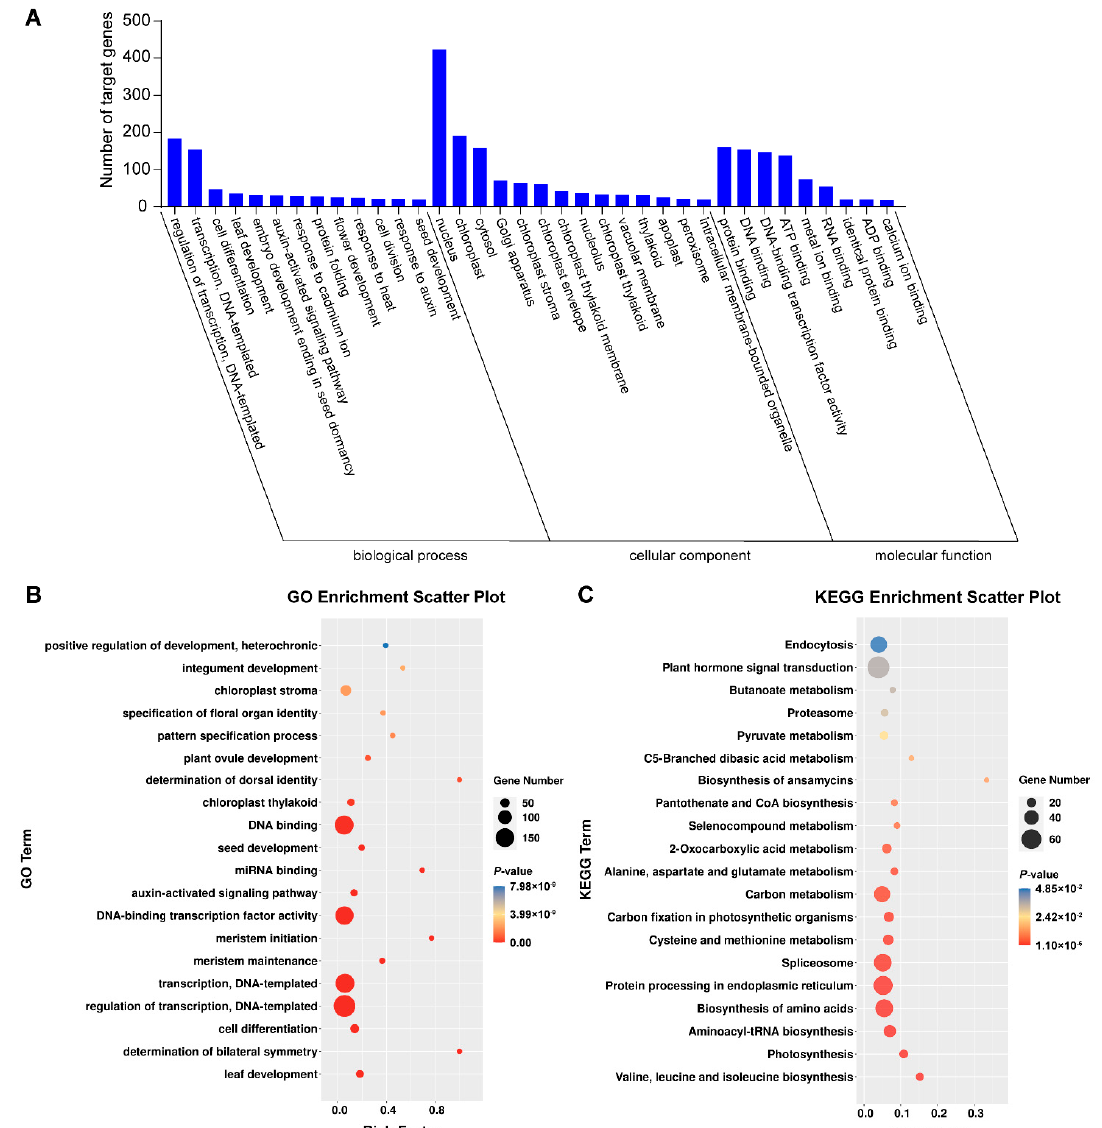
Figure 4. Gene Ontology (GO) ( A ) and Kyoto Encyclopedia of Genes and Genomes (KEGG) ( B , C ) analysis of target genes in degraded group.